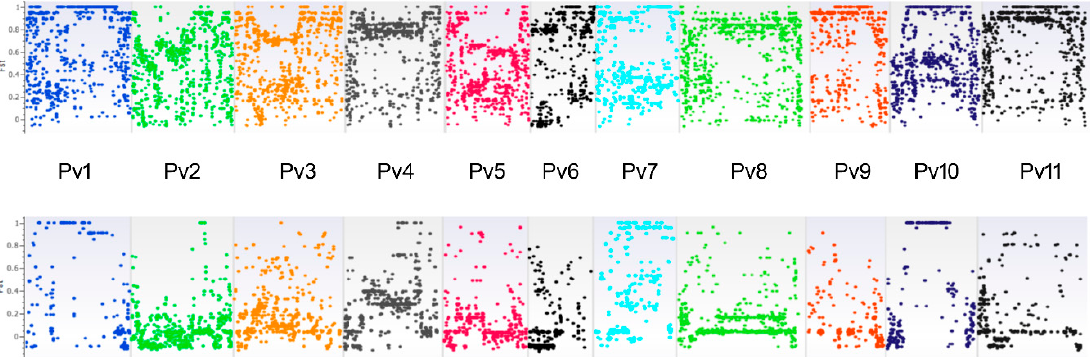
Figure 3. Fixation index (F ST ) for SNPs analyzed between ( A ) Mesoamerican and Andean accessions and ( B ) within Andean groups. Each bar represents a common bean chromosome. From left to right, Pv1 to Pv11. Each color refers to a common bean chromosome.